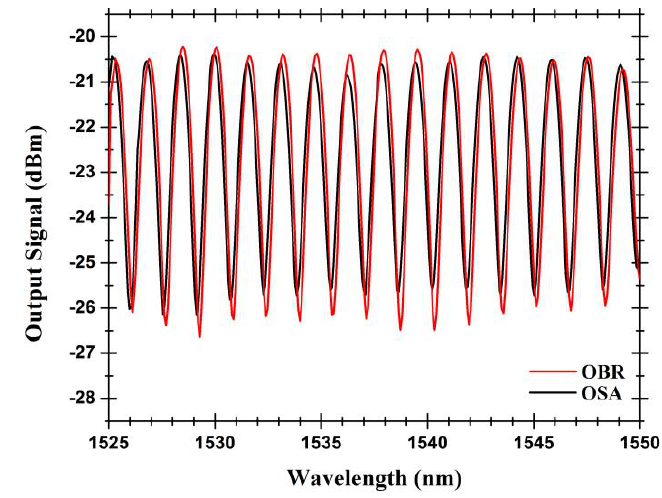
Figure 5. Output signals of the hybrid Fabry-Pérot cavity measured by the two different optical instruments (optical spectrum analyzer (OSA) and